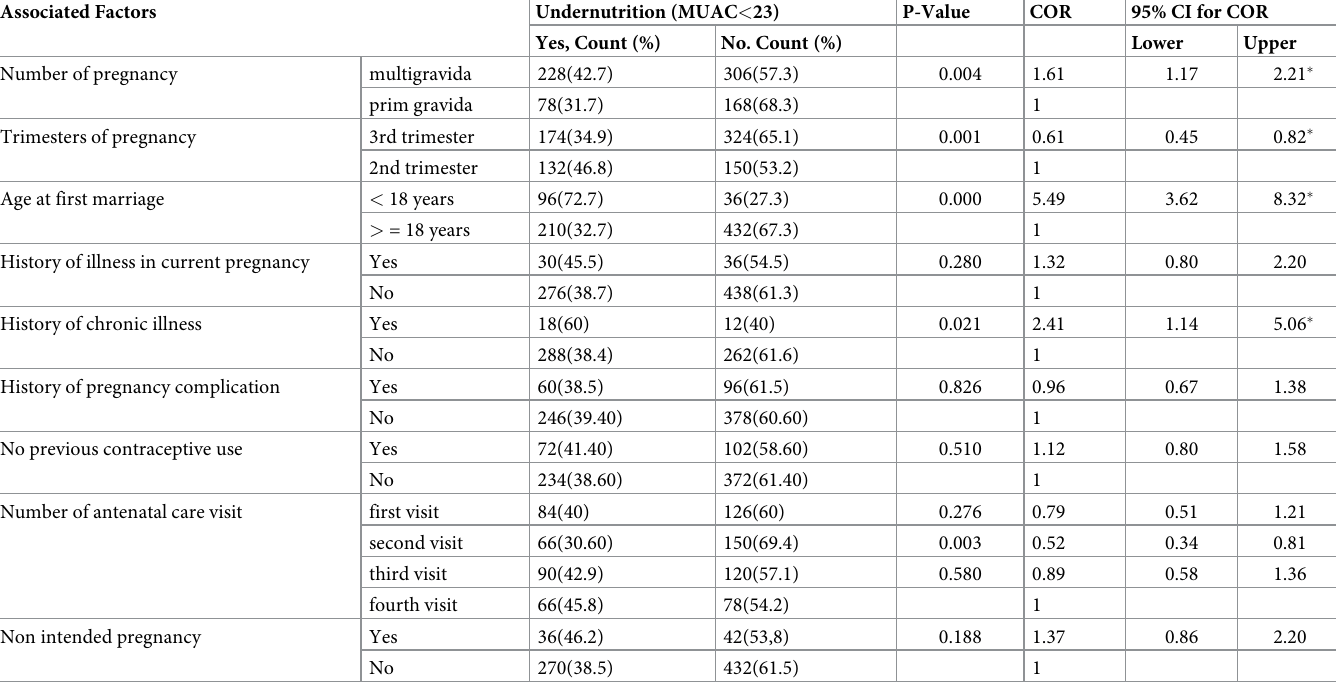
Table 6. Bivariate analysis of reproductive and medical factors associated with under nutrition among participants attending ANC services at West Wollega public hospitals, 2020. Associated